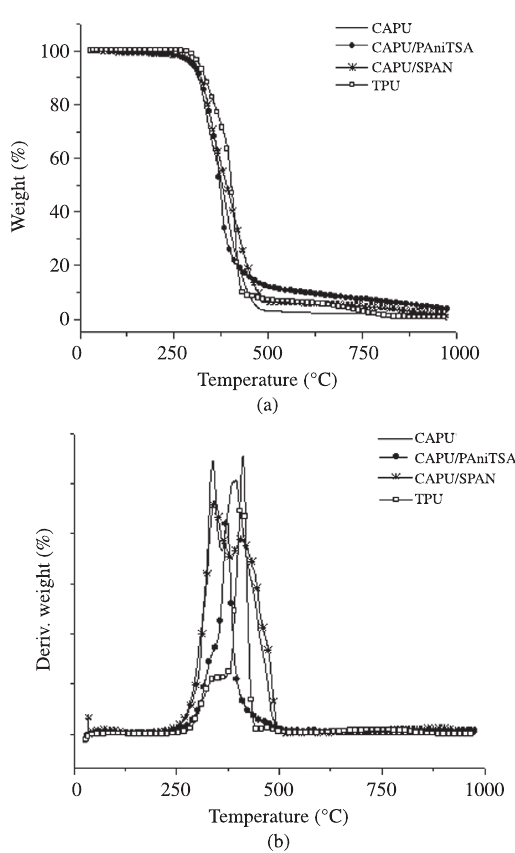
Figure 5. TGA (a) and DTG (b) of CAPU, TPU and CAPU/SPAN, CAPU/PAni TSA